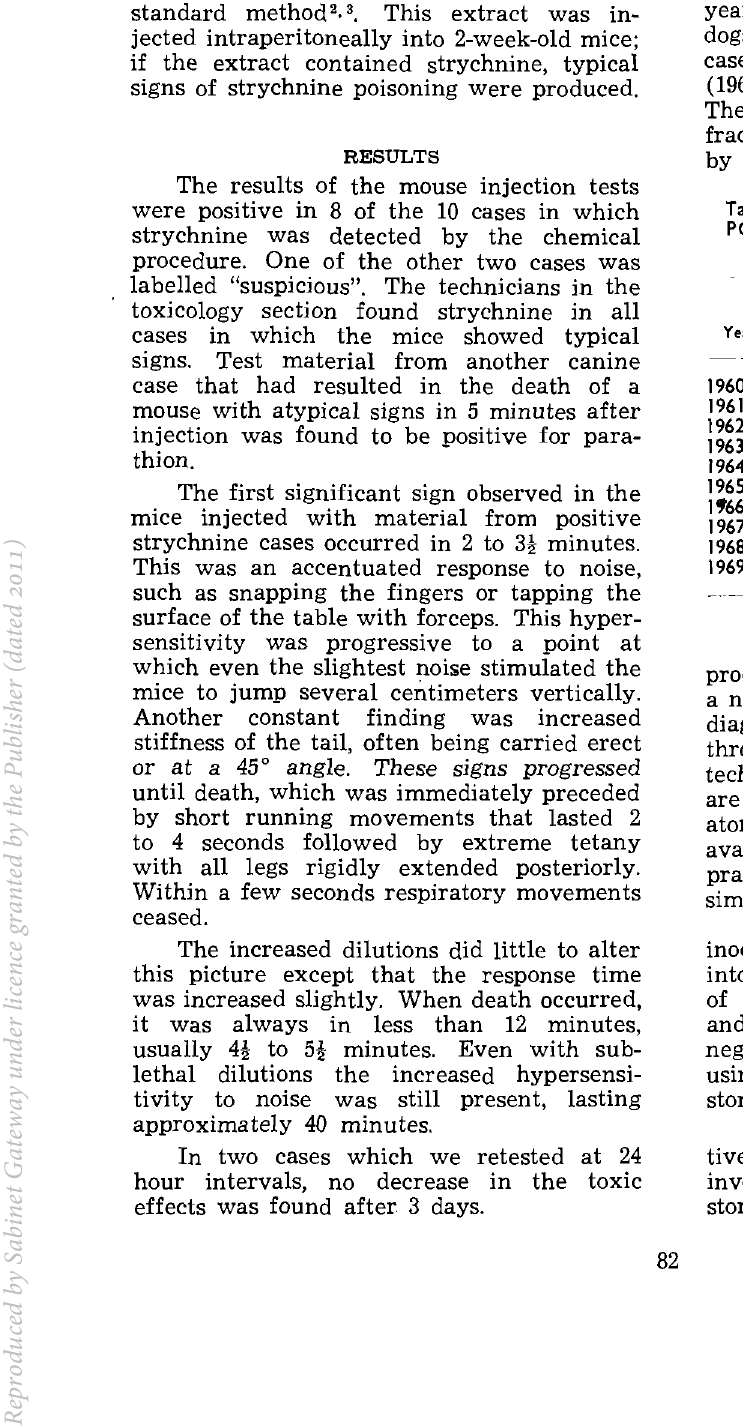
Table 1: CASES OF SUSPECTED STRYCHNINE POISONING SUBMITTED TO THE